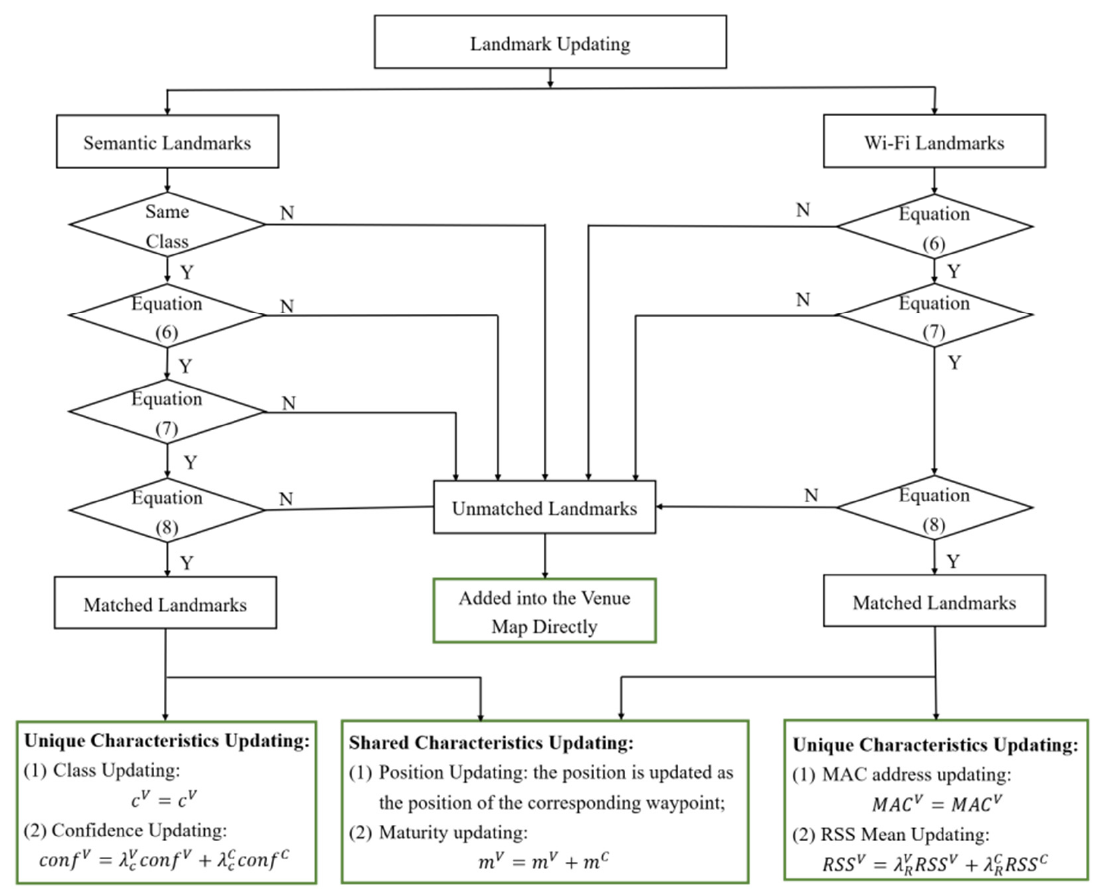
Figure 5. The flow chart of landmark updating. Finally, after updating all of the waypoints and landmarks, the association relationship between the waypoints, semantic landmarks, and Wi-Fi landmarks is